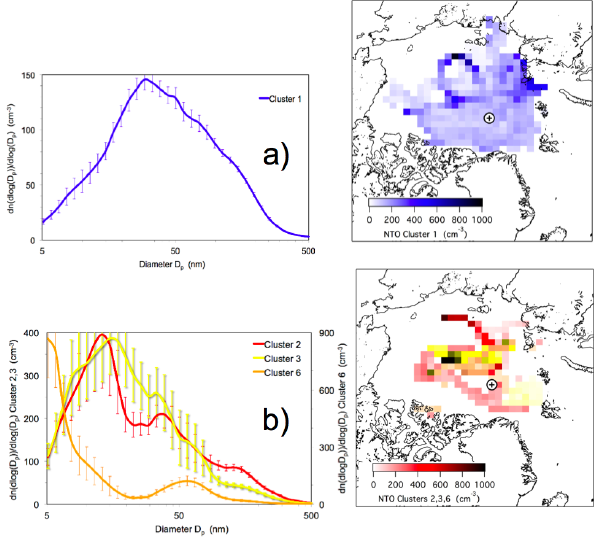
Figure 8. Left: average particle number size distributions of the four clusters of horizontal trajectory coordinates, combined with particle size distributions in the open water subpopulation. The clusters are separated into (a) pack ice low and (b) pack ice high. Error bars show 1 standard deviation about the group average. Blue shows cluster 1; yellow shows cluster 3. Right: corresponding regional distributions of median total number concentrations (NTO, cm − 3 ) . The color saturation indicates the total number associated with the respective trajectory. Only geocells with at least 25 trajectory hits are shown. The plus symbol indicates the North